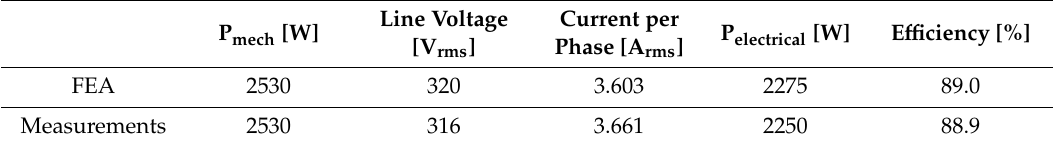
Table 2. Results of the investigated generator at 1500 rpm and 56 ohm load. Figure 10. Efficiency and reactive power ratio measurements at 1500 rpm.